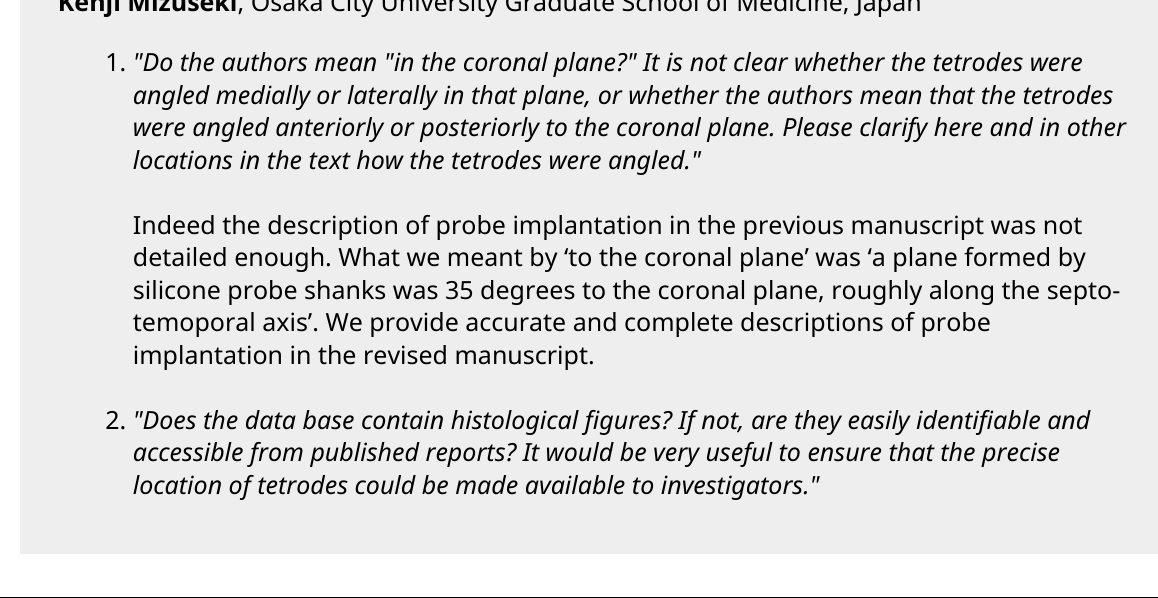
Table 1, ' elevated linear track ': Shouldn't the fixed angles be 74 degrees (i.e. +/- 37